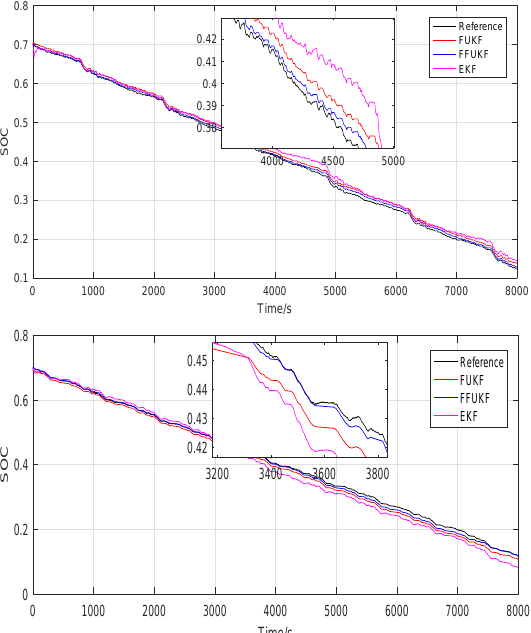
Figure 14. The SOC estimation curves under BJDST and FUDS at 45 ◦ C.